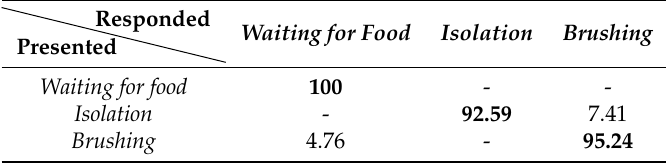
Table 3. The confusion matrix (in %) representing the classification results achieved by the DAG-HMM. PresentedResponded Waiting for